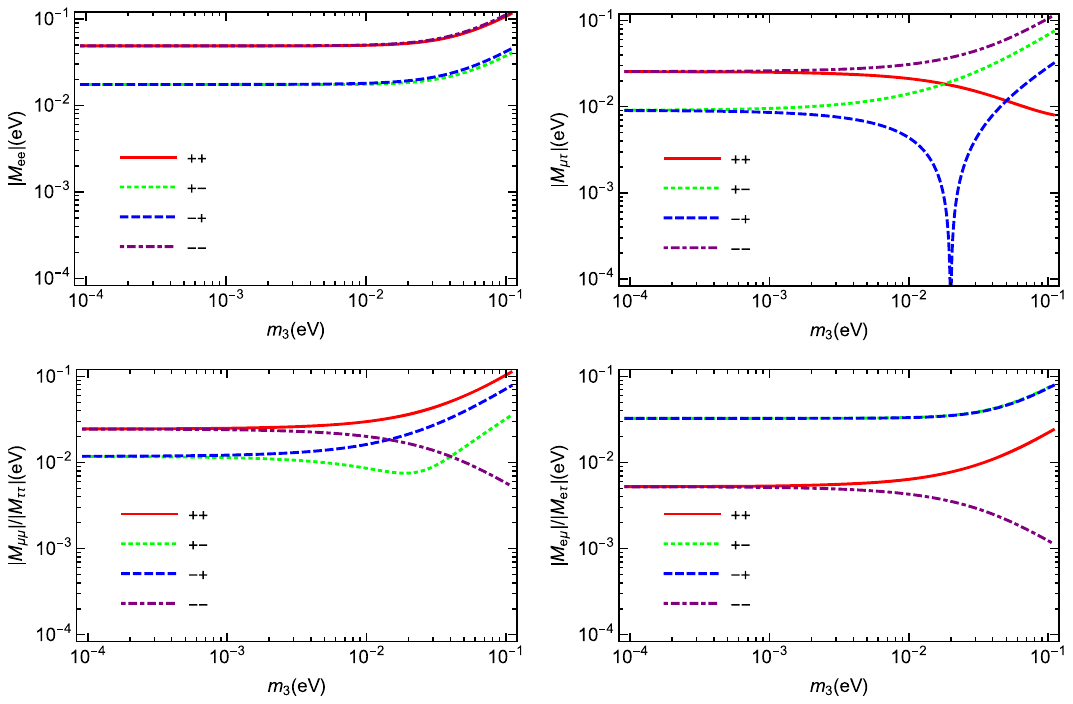
Fig. 4 In the TM1 μ - τ reflection symmetry scenario, | M αβ | as functions of the lightest neutrino mass m ( 1 , 1 ),( 1 , − 1 ),( − 1 , 1 ) and ( − 1 , − 1 ) (denoted as ++ , −+ , +− and −− ,